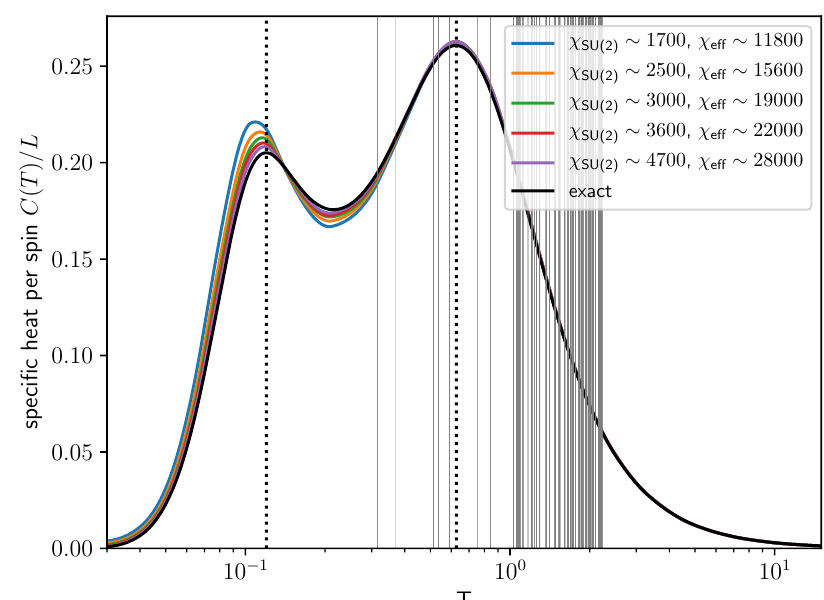
0 . 10 1 T Figure 10: Specific heat of the dodecahedron for different bond dimensions. The = 300,400,500,600,800. bond dimension per subspace was limited to χ sub,SU(2) The grey vertical lines indicate the first 1000 eigenenergies relative to the ground − E state, E . The dotted vertical lines indicate the peak positions from Ref. [ 26 ] . n 0 To obtain the exact result, we used the Kernel Polynomial Method [ 75 ] with 1000 lowest eigenstates, 1000 Chebyshev moments and 1000 random